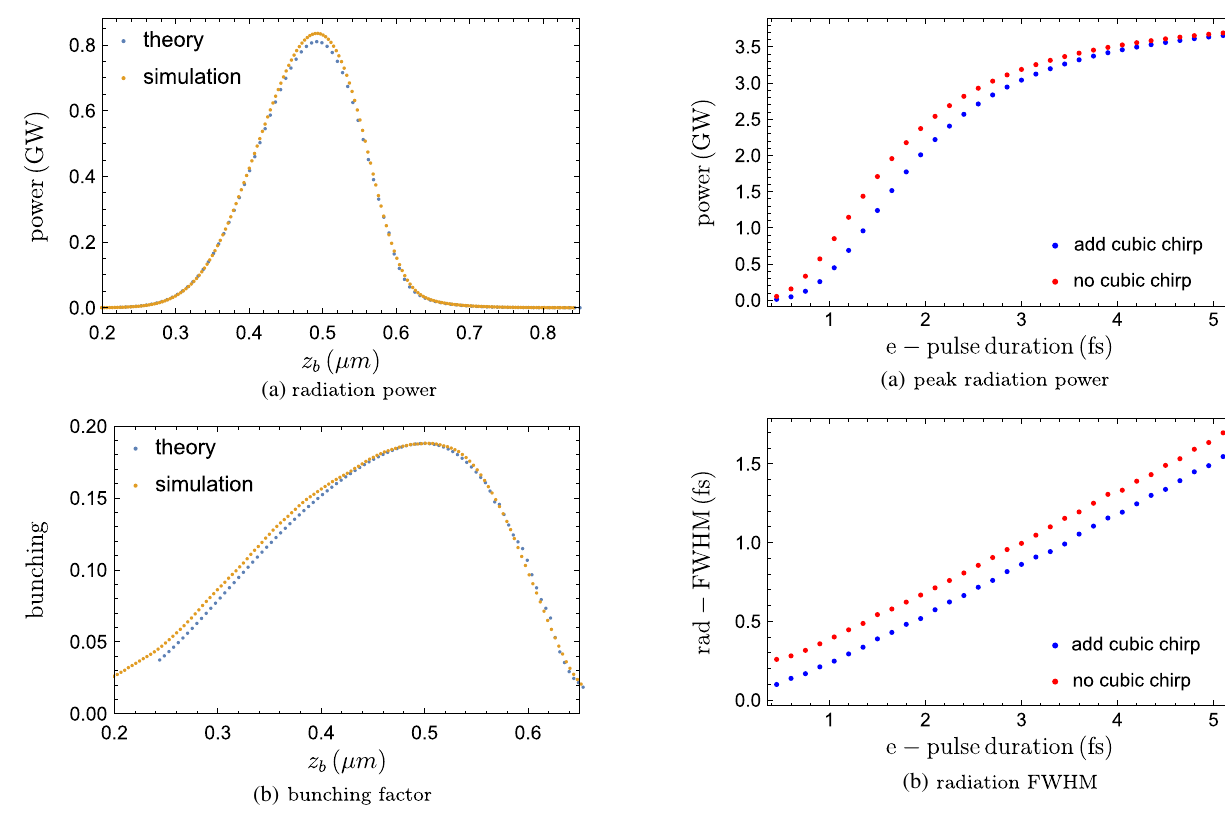
FIG. 5. Radiation peak power and FWHM vs the electron bunch length (same color convention as in Fig. 4).